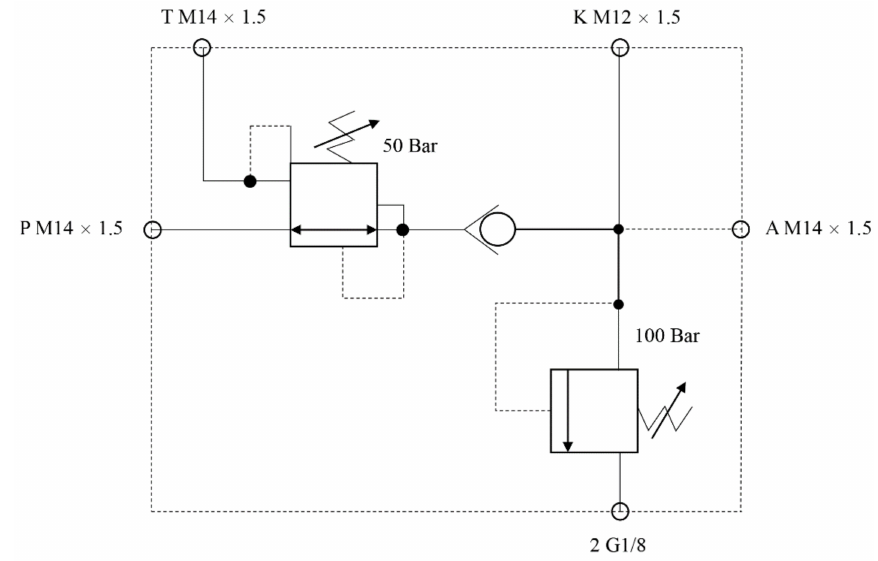
Figure 7. Waterproof valve internal oil circuit diagram.